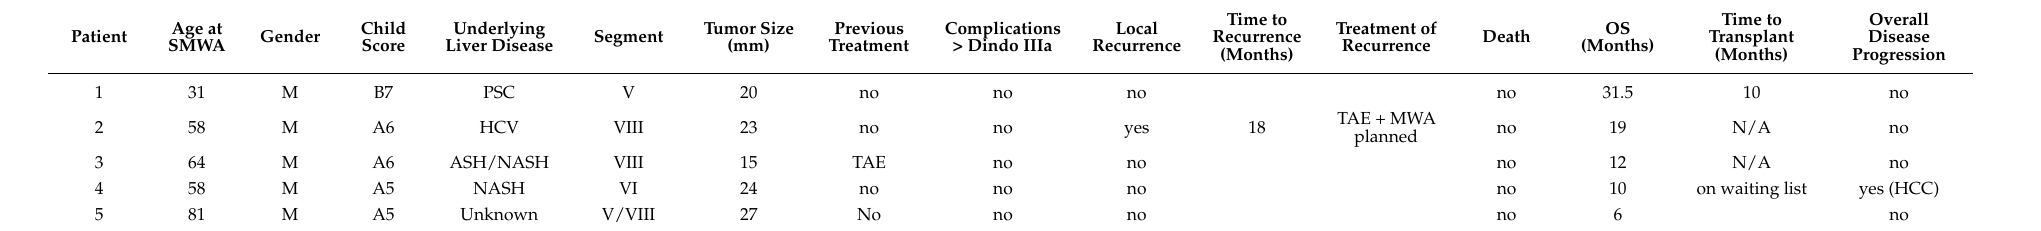
Table 2. Patients with primary ICC treated by SMWA.